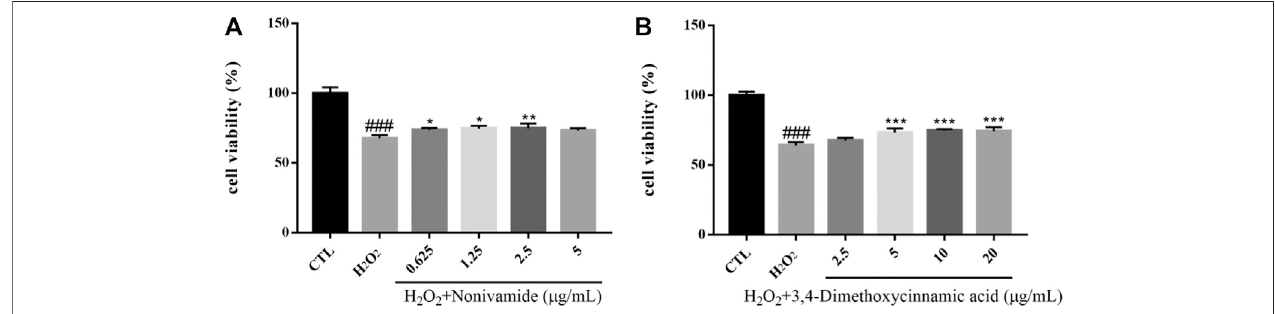
FIGURE12| VariousconstituentssuppressedH 2 O 2 -inducedcytotoxicityinSH-SY5Ycells.Cellswerepre-treatedwithdifferentconcentrationsofNonivamide (A) , 3,4-Dimethoxycinnamic acid (B) or 0.1% DMSO for 2 h and then incubated with or without H 2 O 2 (400 μ M) for 24 h and the cell viability was detected by MTT assay. Results are shown as the mean ± SEM and represent three independent experiments. ### p < 0.001 compared with control group, * p < 0.05, ** p < 0.01, *** p < 0.001 compared with